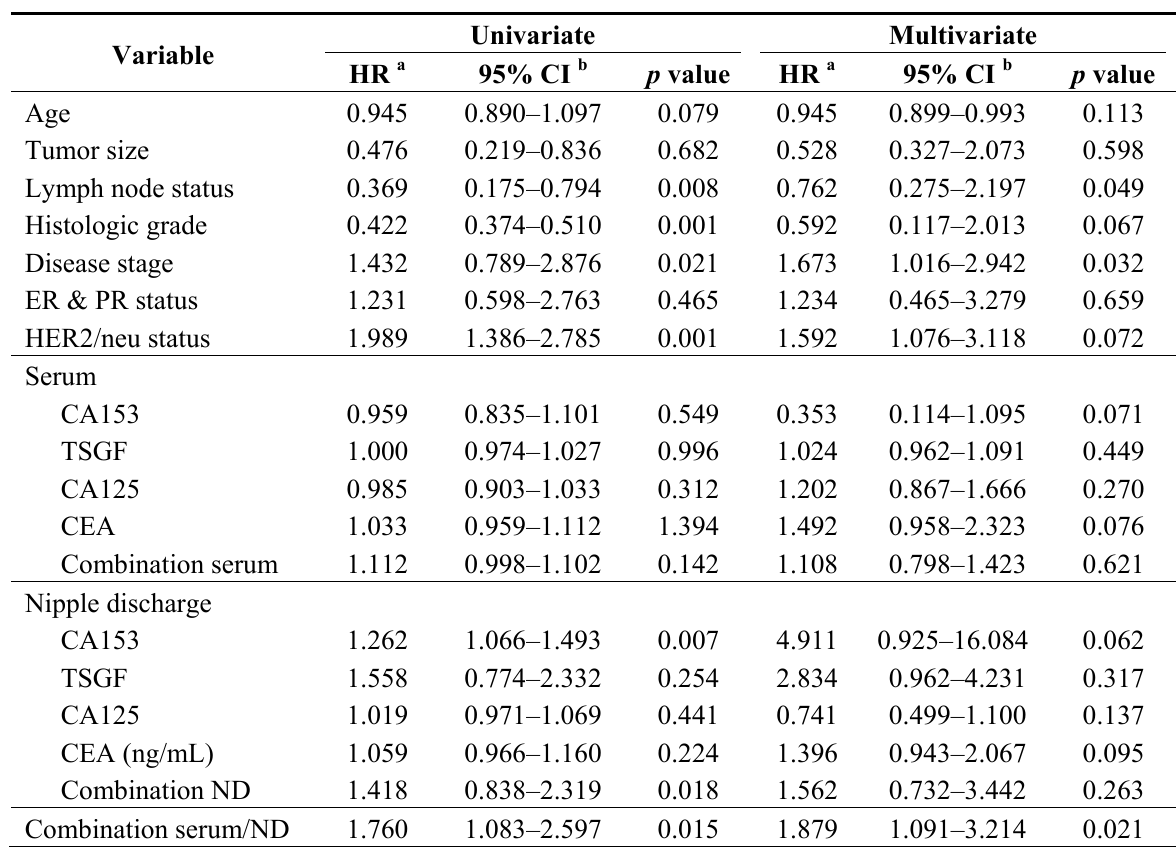
Table 5. Univariate and multivariate overall survival analysis of clinicopathological